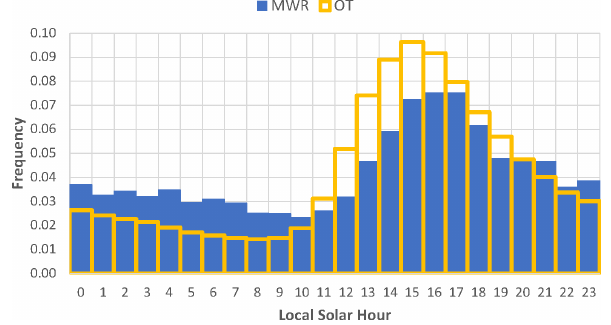
Figure B1. Variation in OT activity throughout the day, estimated with the OT method (yellow) and passive microwave detection (blue), normalized by the total number of